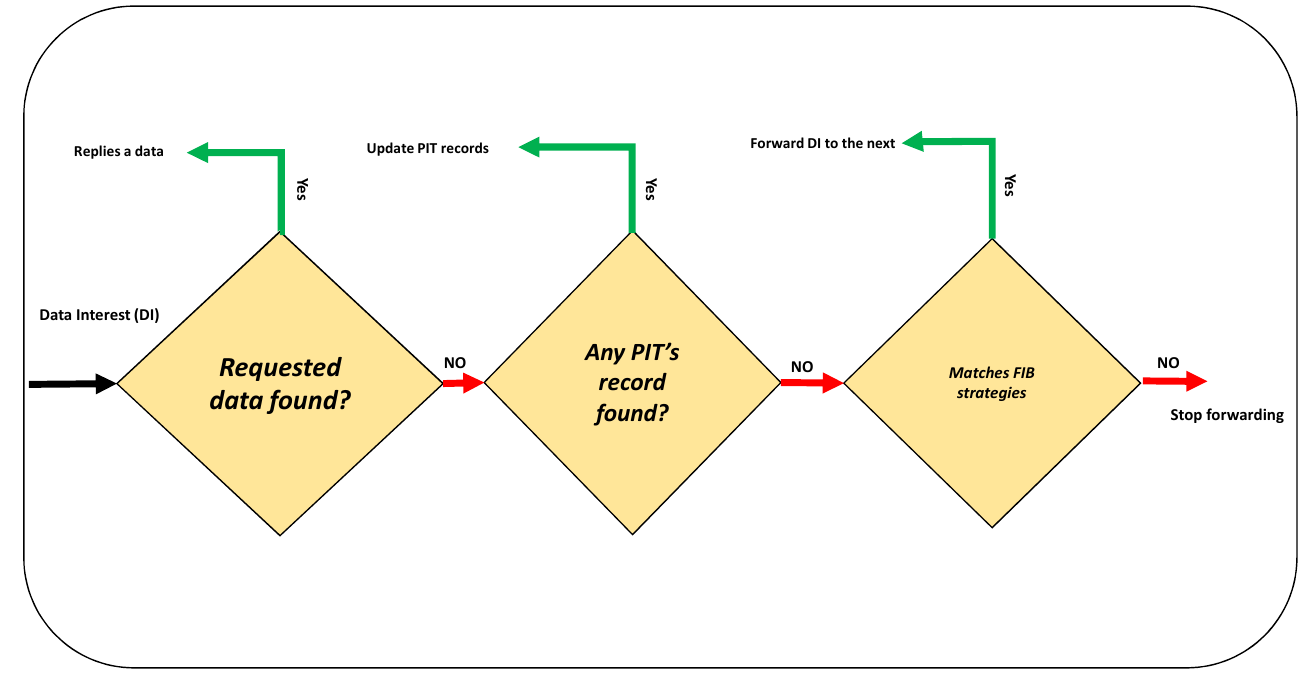
Figure 1. NDN conceptual